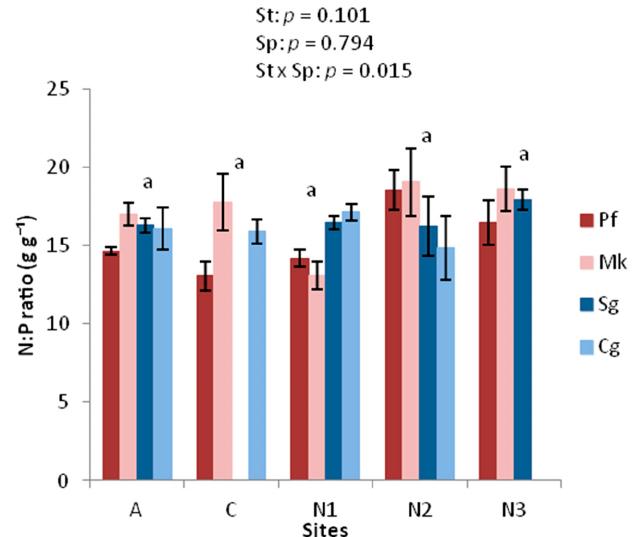
Figure 7. Nitrogen to phosphorus ratio (N:P ratio) of four species (Sp) at five sites (St) along an elevation gradient. Error bars represent standard error. Significant overall differences among sites are indicated by different letters above the bars of each site. Explanations of site abbreviations and species names are provided in Table 1 and Figure 1, respectively; the site order follows increasing elevation from left to right.